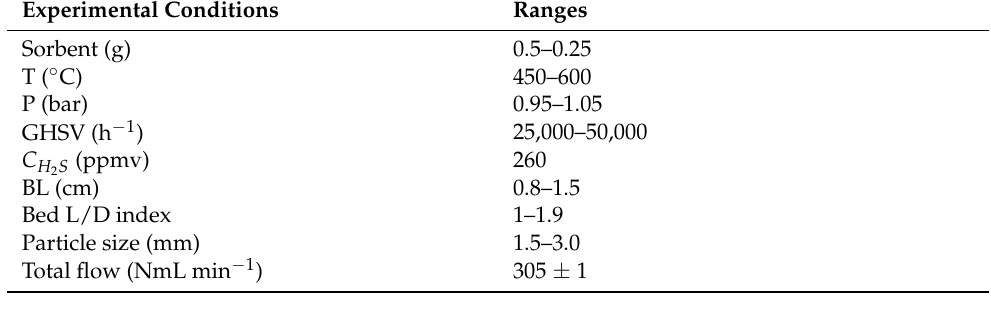
Table 3. Sorbent experimental setup using syngas.